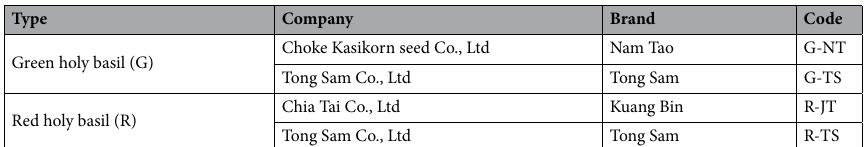
Table 1. List of four holy basil varieties from three seed companies, brand, and coding name of holy basil plants grown in PFAL